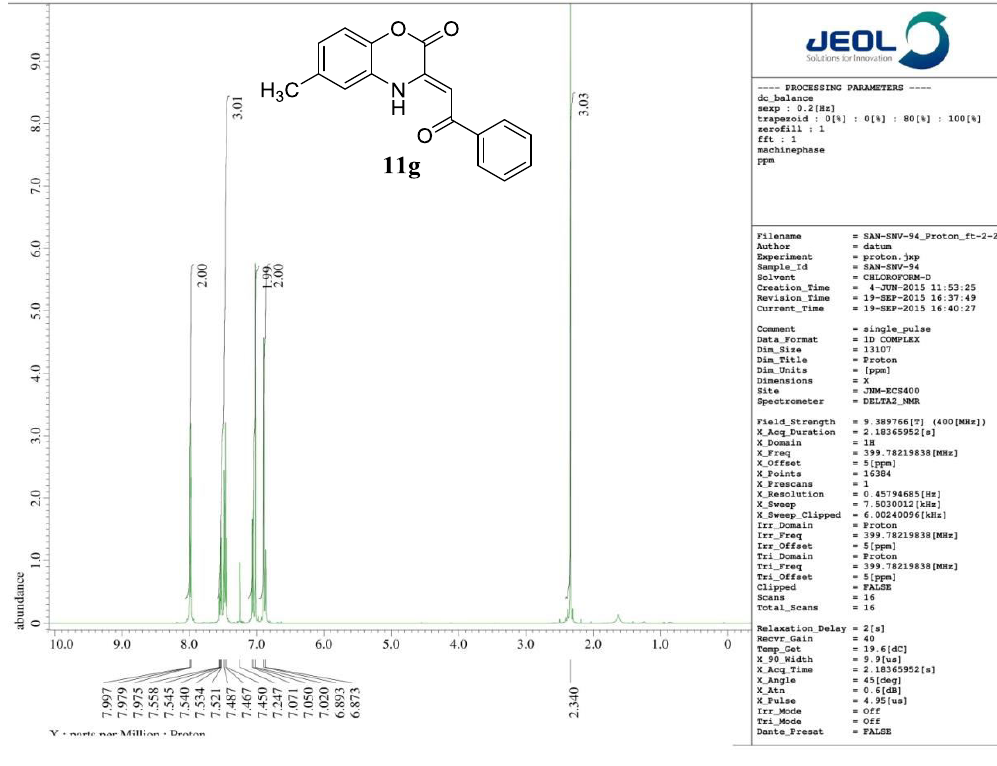
Figure 13. 1 H NMR Spectra of Compound 11g.